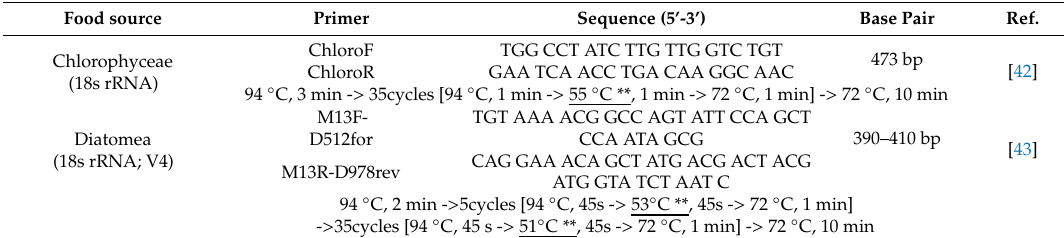
Table 2. PCR primers used for detecting rotifer food